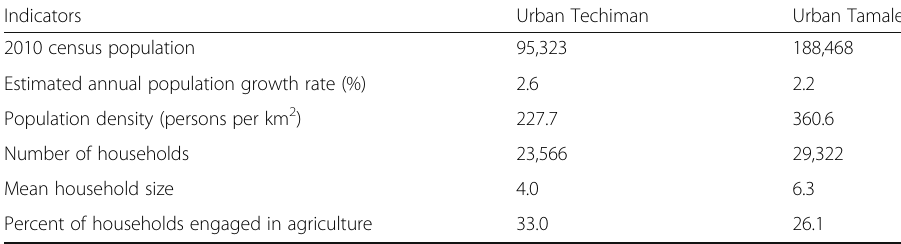
Table 1 Selected characteristics of the two cities